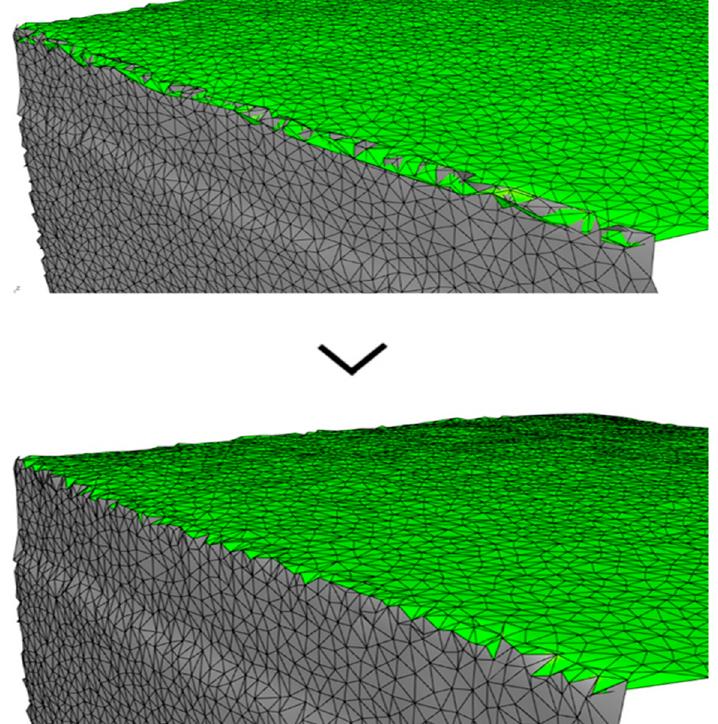
Figure 11. Crease processing between adjacent meshes.